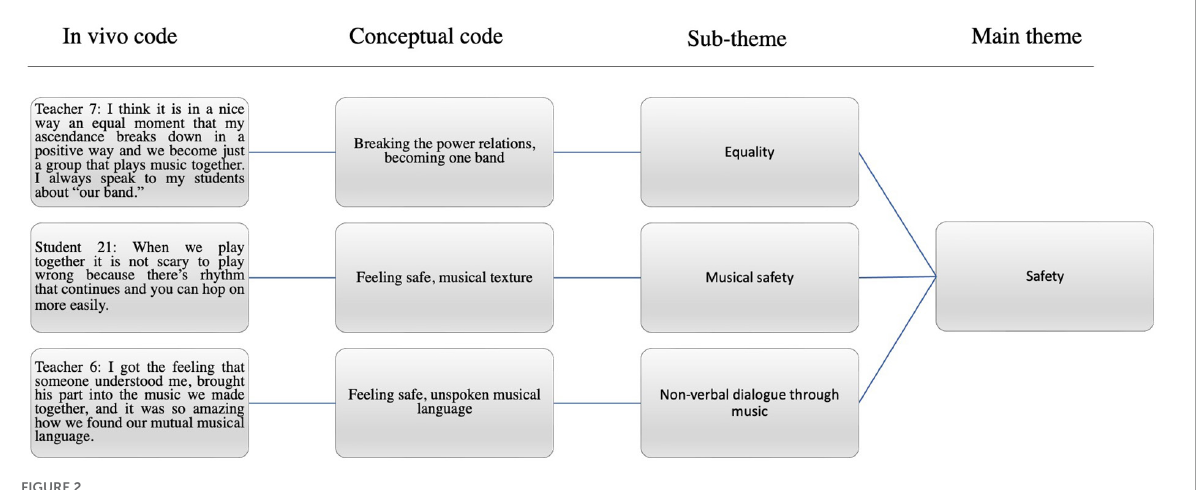
FIGURE2 Phases of coding and theme